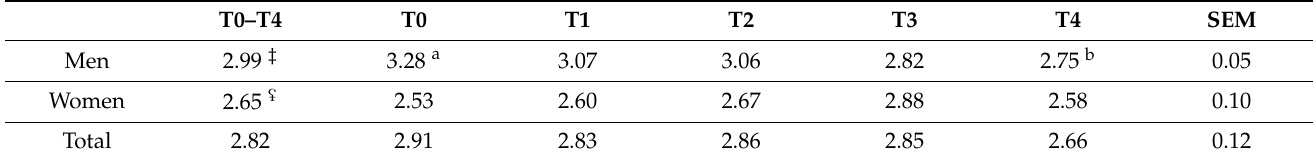
Table 8. Effect of tannin supplementation on sensory evaluation of